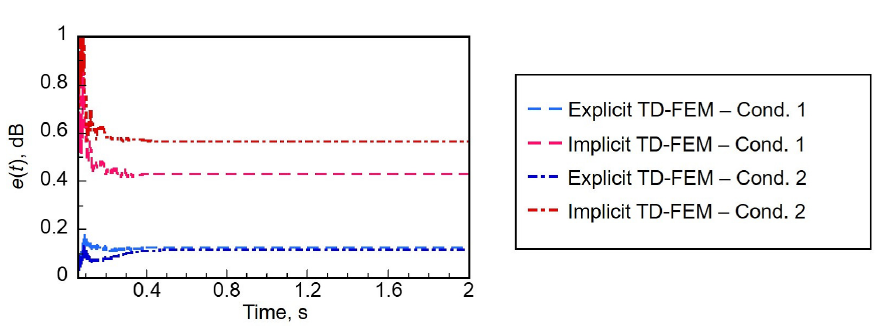
Figure 15. Comparison of absolute errors in time integrated sound pressure levels between the proposed explicit TD-FEM and the standard implicit TD-FEM for Cond. 1 and Cond.